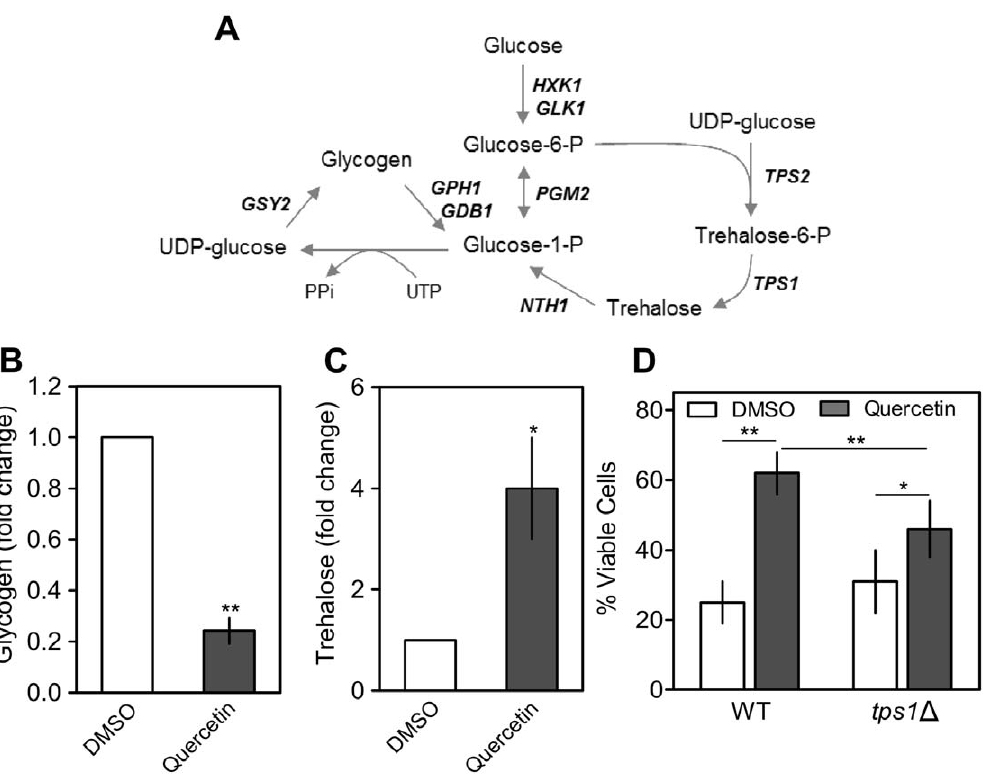
Figure 4. Quercetin causes glycogen depletion and increases trehalose levels. (A) Schematic representation of genes up regulated in cells treated with quercetin related with glycogen and trehalose metabolism. (B, C) S. cerevisiae BY4741 cells were grown to exponential phase and treated with 300 m M of quercetin or equal volume of DMSO (vehicle) for 15 min. (B) Glycogen and (C) trehalose levels were measured as described in Materials and Methods . Values are mean 6 SD of three independent assays. *p , 0.05; **p , 0.01 (paired t-test). D) Hydrogen peroxide resistance. S. cerevisiae BY4741 (WT) and tps1 D cells were treated with 300 m M of quercetin or equal volume of DMSO (control cells) for 15 min and subsequently exposed to 1.5 mM H 2 O 2 for 1 h. Cell viability was determined by standard dilution plate counts and expressed as the percentage of the colony- forming units of non-stressed cells. Values are mean 6 SD of at least three independent assays. **p , 0.01; *p , 0.05 (two-way ANOVA).